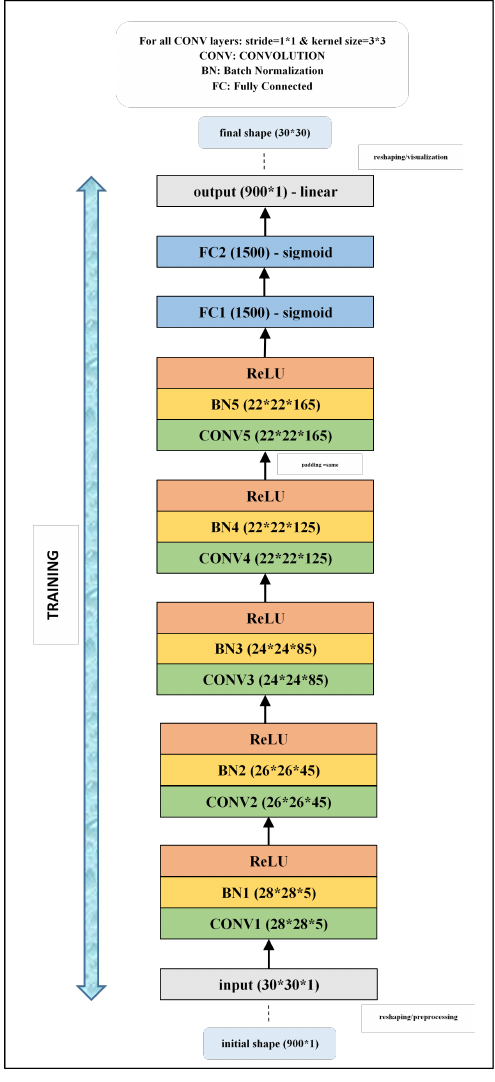
Figure 2. The structure of the CNN model used in this